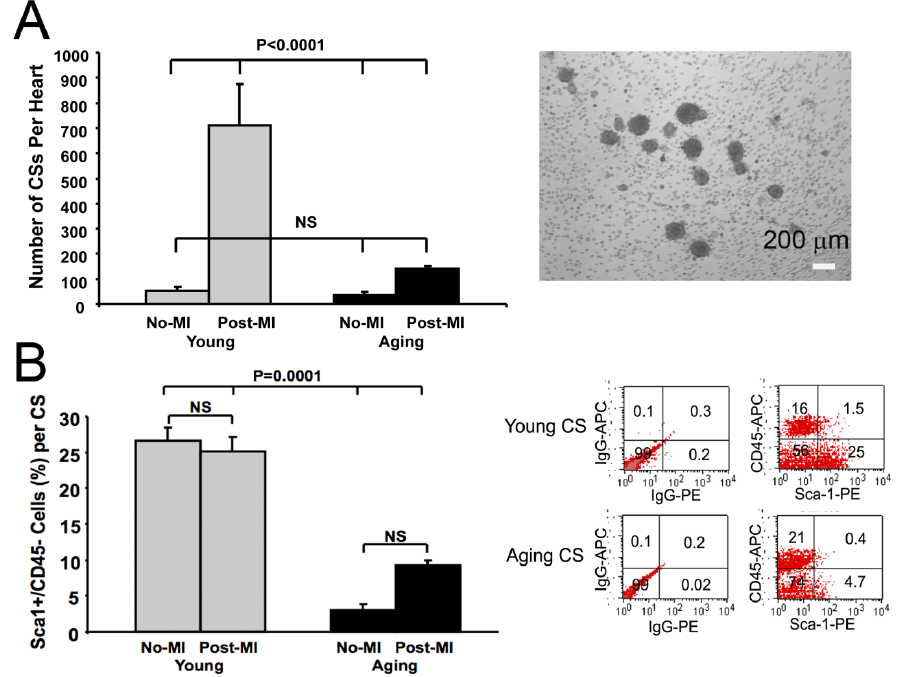
Figure 2. Age limits the proliferative capacity of cardiac progenitors following MI. ( A ) The number of CSs from young and aging murine hearts at baseline was not significantly different. The number of CSs from injured young hearts ( n = 10) was much more than those from non-injured young hearts ( n = 5). Aging blunts the proliferative response seen after MI. The number of CS generated from non-injured ( n = 16) or injured ( n = 13) aging hearts is similar. Cardiospheres are seen as self-assembling clusters of cells; ( B ) Bar graph showing the percentage of Sca-1 + /CD45 − cardiac progenitor cells within CSs from young or aging hearts at baseline or 1-week post-MI by FACS ( n = 5–8). Data in figure shown as mean ±